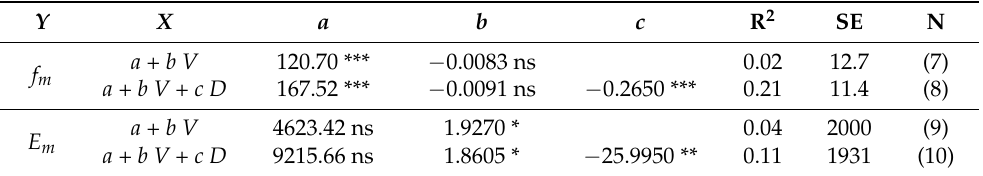
Table 6. Coefficients of the regression model for bending strength ( f m ) and static modulus of elasticity ( E m ) estimation. V = stress-wave velocity; D = average diameter at midspan; R 2 = coefficient of determination; SE = standard error of estimation; N = number.